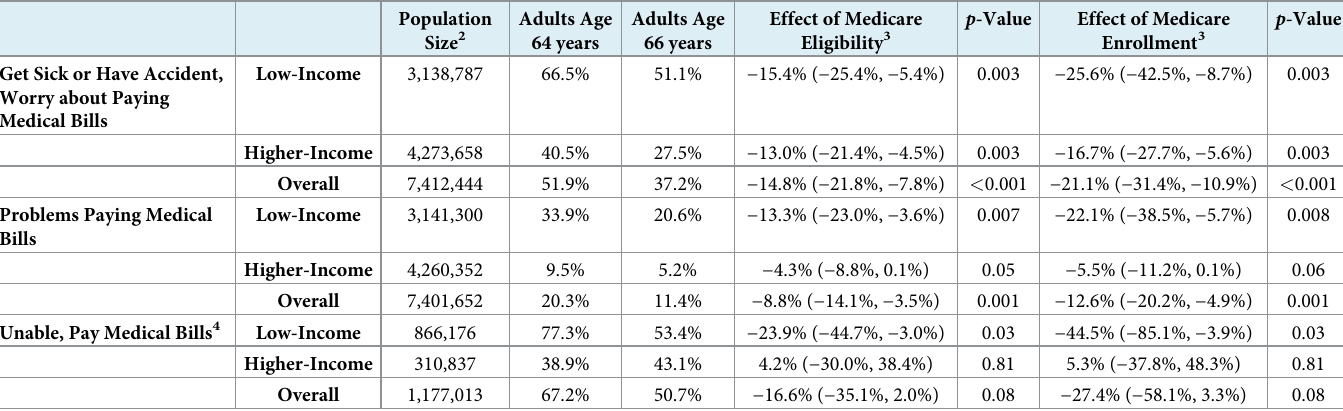
Table 4. Association of Medicare eligibility and enrollment with financial strain due to medical bills by income level 1